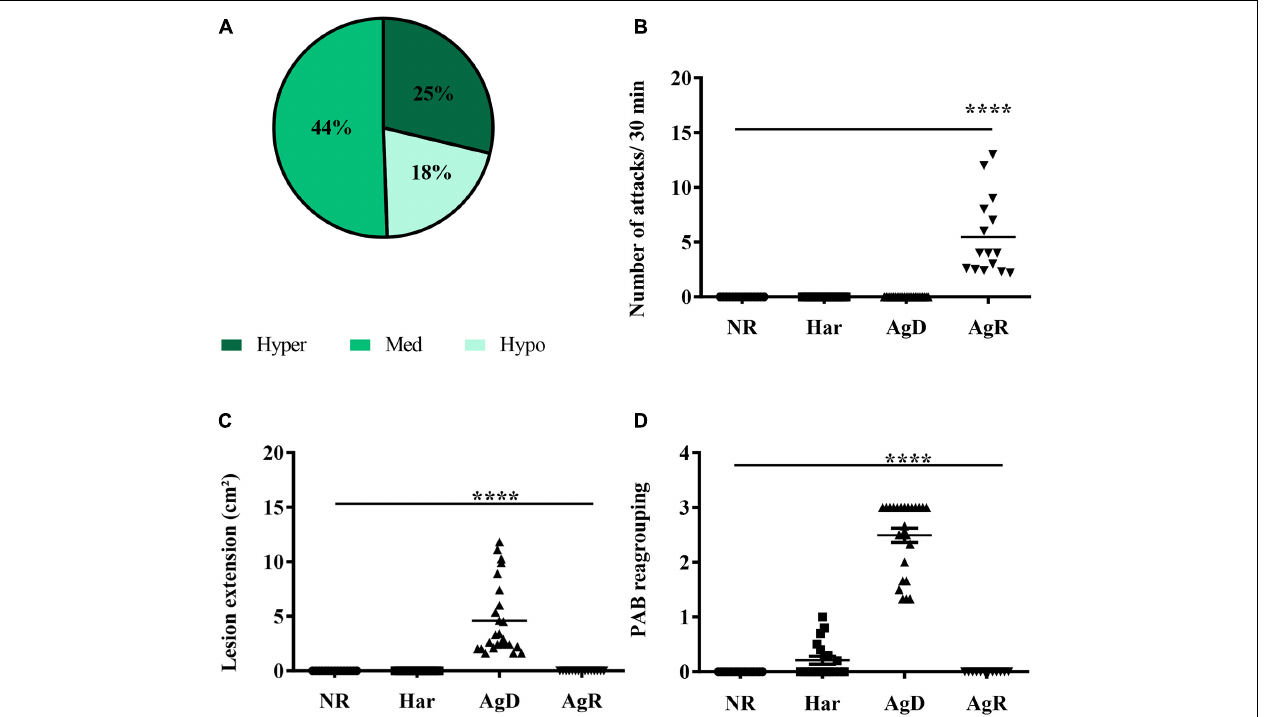
FIGURE 2 | Evaluation of behavioral parameters in social stress. (A) Distribution of animals according to the mobility profile obtained by the TST for the regrouping in the 10th week of life. In the grouping, we obtained: Dark green: Hyperactive (25%); Green: Medium (44%); Light green: Hypoactive (18%). (B) Number of attacks130 min after the regrouping, according to the categorization of animals in NR (non-regrouped) (black circle), Har (harmonic) (black square), AgD (defeated) (black triangle), and AgR (aggressive) (inverted black triangle) animals. (C) Lesion extension (cm2) after the regrouping, according to the behavioral categories of NR, Har, AgD, and AgR animals. (D) Evaluation of the pattern of aggressive behavior (PAB) after the regrouping, according to the behavioral categories of NR, Har, AgD, and AgR animals. The PAB test was performed through an individual physical inspection of all animals, enabling the quantification of aggression according to predetermined scores: (0) mice with no bites or injuries on the body; (1) reduced aggressive non-sexual events and discrete bite signs on the back or tail; (2) aggressive events and moderate lesions on the tail, back, and scrotum; and (3) severe events of aggression and marked lesions on the tail, back, and scrotum. The values are expressed according to the individual results of the mice from three independent experiments (NR; n = 15, Har; n = 20, AgD; n = 25, AgR; n = 15 animals). **** corresponds to significance ( p < 0.0001) between AgR and the other categories and AgD and the other categories by Kruskal-Wallis and Dunn’s test.